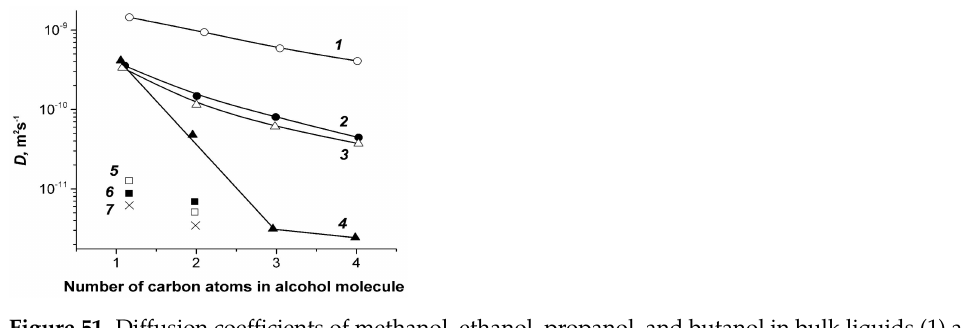
Figure 51. Diffusion coefficients of methanol, ethanol, propanol, and butanol in bulk liquids (1) and MF-4SC membranes in various ionic forms. Membrane ionic form: (2) Li + , (3) H + , (4) Na + , (5) Cs + , (6) Rb + , (7) K + (adapted from [47]).